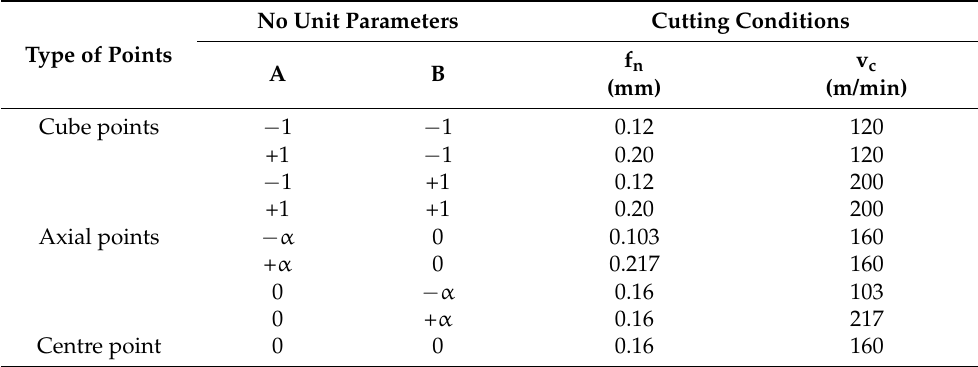
Table 4. Design of experiments for uncoated CTI.